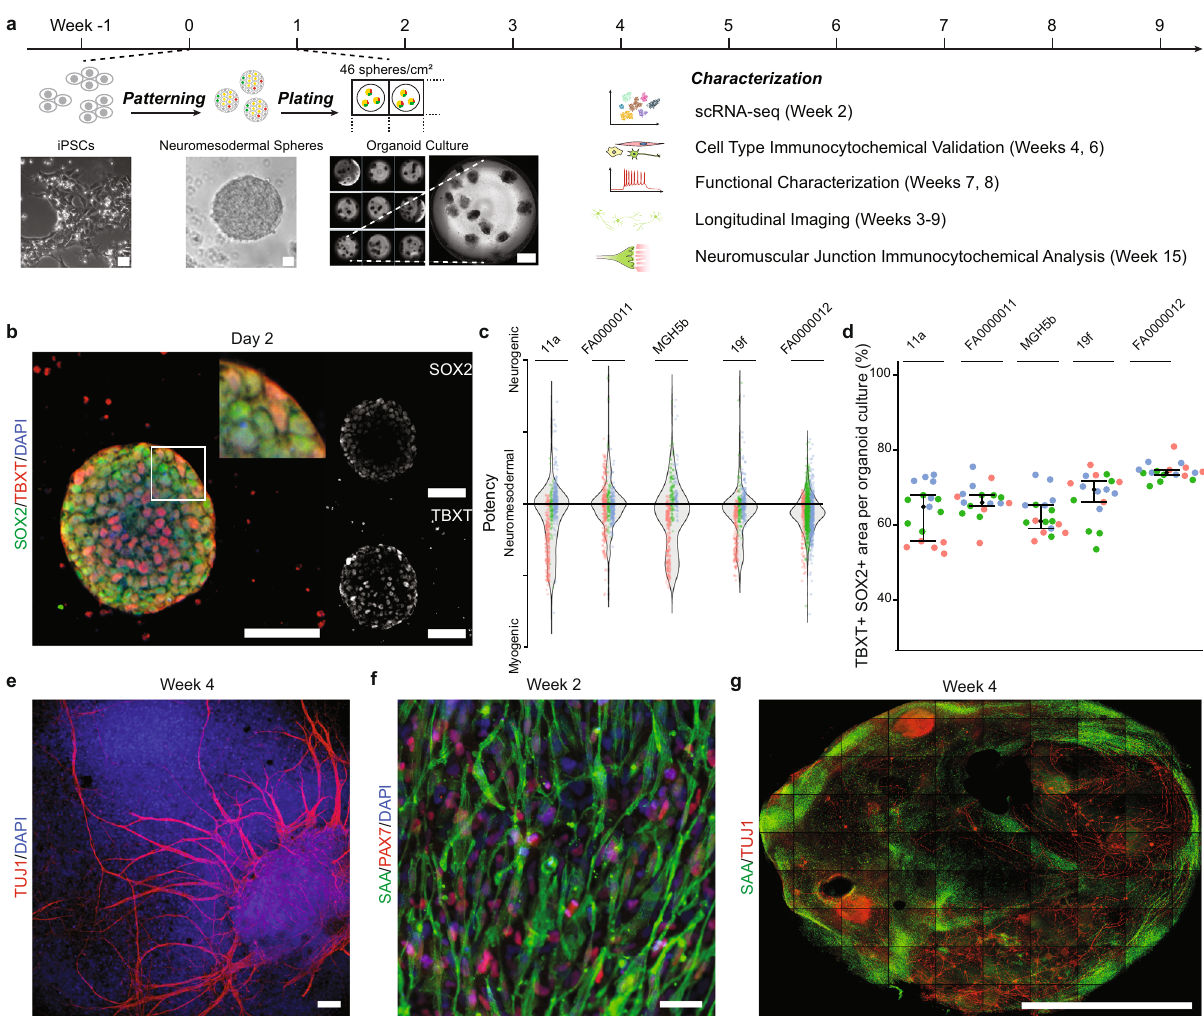
Fig. 1 Spheres containing neuromesodermal progenitors generate neurons and myocytes. a Sensorimotor organoid differentiation protocol and end-point analysis times. Spheres patterned in suspension are plated after 1 week and grown under adherent conditions for up to 15 weeks. Scale bars are 40 µ m for the fi rst two panels, and 1 mm for the third panel. b SOX2 + /TBXT + neuromesodermal progenitors in a typical sphere, after two days in culture. Scale bar, 70 µ m. c Distribution of individual spheres according to the expression of myogenic (TBXT), neuromesodermal (TBXT and SOX2), or neurogenic (SOX2) transcription factors, from three independent biological differentiation replicates of each line (colors indicate replicates). Control lines: 11a, FA0000011. ALS lines: MGH5b, 19f, and FA0000012. d Quanti fi cation of the SOX2 + /TBXT + area in whole wells of the same iPSC lines. Bars indicate median and IQR. ( n = 5 – 6 organoid cultures obtained from three independent biological differentiation replicates of each of the same fi ve iPSC lines). e Ectodermal lineage cells, including TUJ1 + neurons after 4 weeks in culture. Scale bar, 120 µ m. f Mesodermal lineage cells include sarcomeric α -actinin (SAA) + myocytes, surrounded by Pax7 + cells. Scale bar, 50 µ m. g Whole-well confocal image of organoid cultures at 4 weeks showing SAA + and TUJ1 + areas. Scale bar, 5